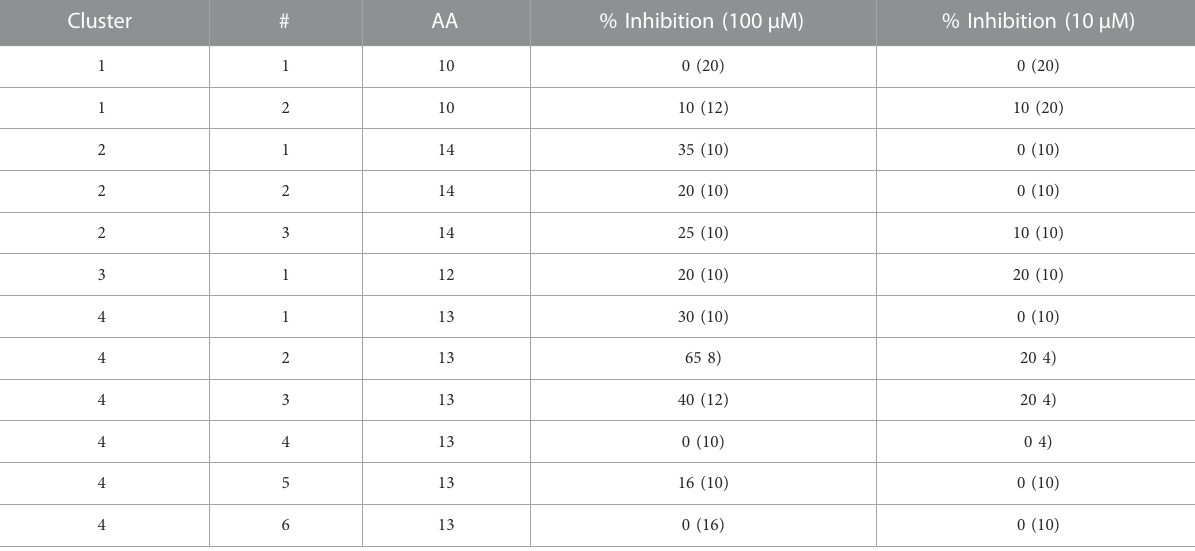
TABLE 1 Peptidomimetics with allosteric spike binding model. Macrocycles representative of four clusters, were synthesized and screened at 10 μ M and 100 µM against a SARS-CoV-2 RVP. The percent inhibition is shown with numbers in parenthesis showing the standard deviation of the mean ( n = 3).